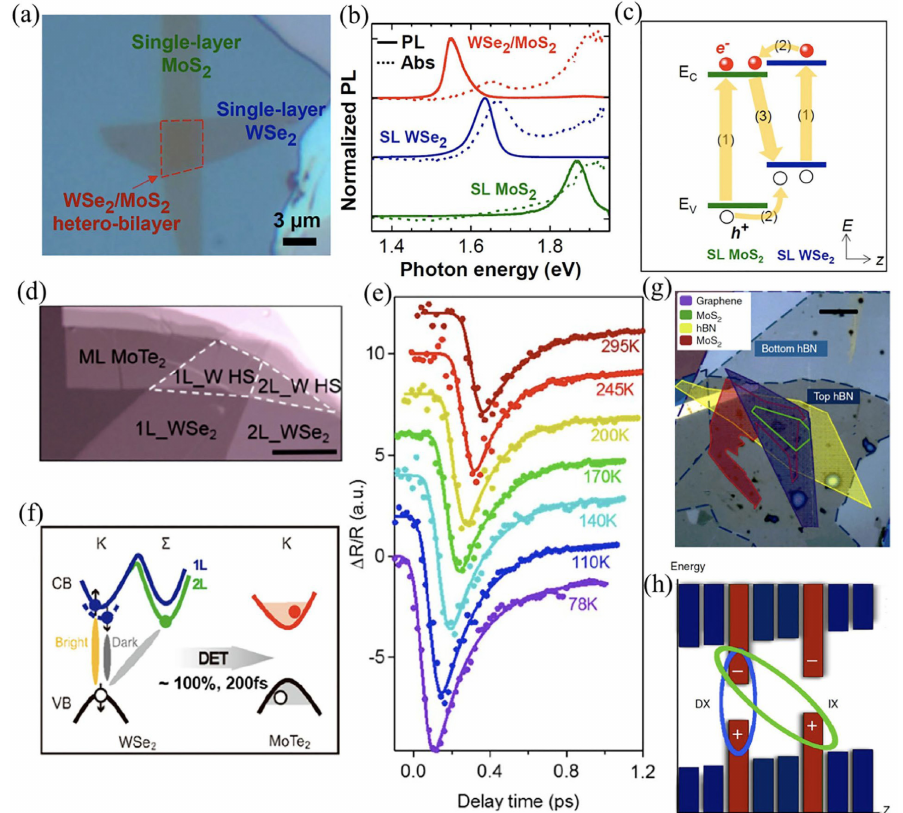
Figure 4. ( a ) Optical microscope images for the hetero-bilayer (WSe 2 /MoS 2 ) over the Si/SiO 2 substrate. ( b ) Normalized PL. ( c ) Energy-band diagram of photoexcited hetero-bilayer WSe 2 /MoS 2 . Adapted with permission from Ref. [91]. Copyright 2014, National Academy of Sciences of the United States of America. ( d ) Characteristic WSe 2 /MoTe 2 samples with monolayer MoTe 2 and bilayer WSe 2 , monolayer WSe 2, and with their heterostructures for monolayer MoTe 2 . ( e ) Transient reflectance (TR) spectra of WSe 2 and exciton bleach-recovery kinetics in WSe 2 /MoTe 2 heterostructures at several temperatures. ( f ) Displays the near-unity transfer of WSe 2 excitons (dark and bright) into free electrons and holes in the MoTe 2 monolayer. Adapted with permission from Ref. [95]. Copyright 2019, American Chemical Society. ( g ) Microscopic images of MoS 2 / h -BN heterostructure. ( h ) Energy- band mapping of MoS 2 / h -BN heterostructure (where IX = indirect exciton; DX = direct exciton). Adapted with permission from Ref. [94]. Copyright 2015, Nature Publishing